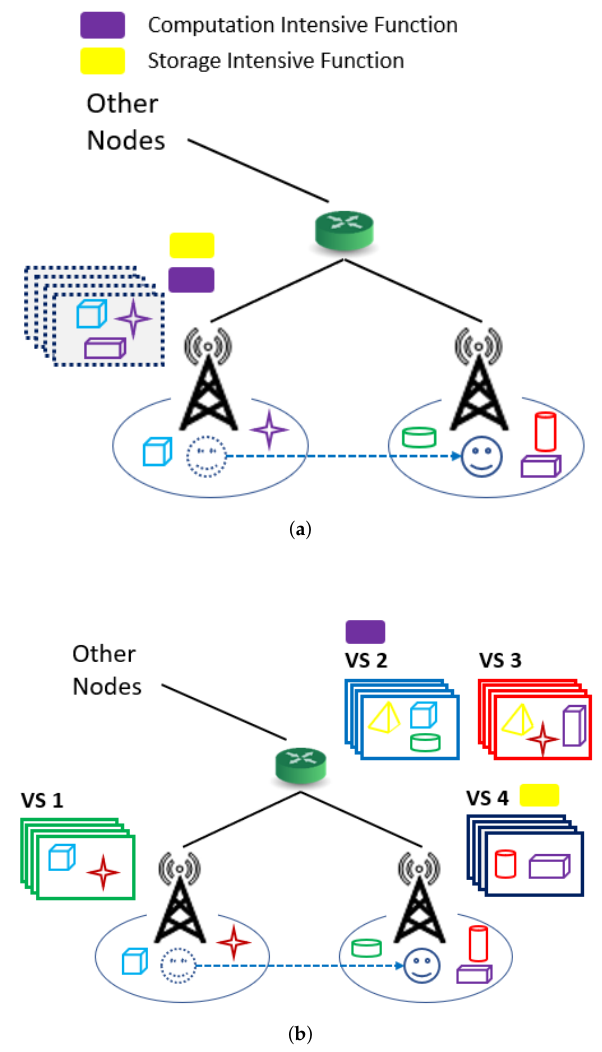
Figure 2. Illustrative toy examples where in case ( a ) mobility is not considered and ( b ) where mobility of the end user is taken into account for service decomposition and the different multi view streams on proactive resource allocation of MAR